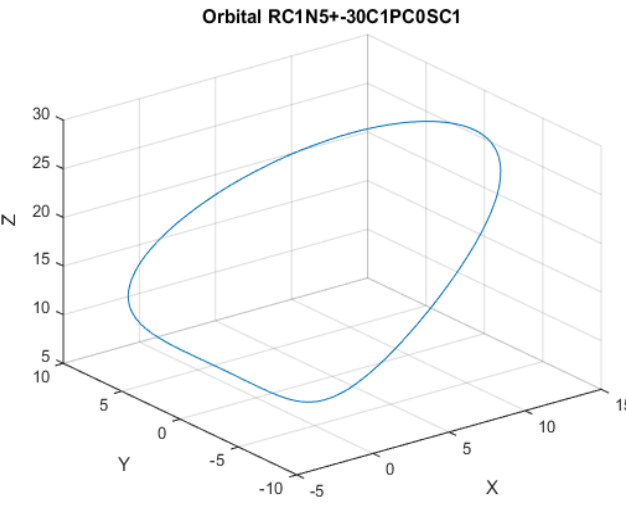
Figure 9: Orbital plot of point Pt1with R (Rocking-Die) at 10 mm amplitude, N (Nutation angle) rotates at 5 O ±30 O , S rotates and P is